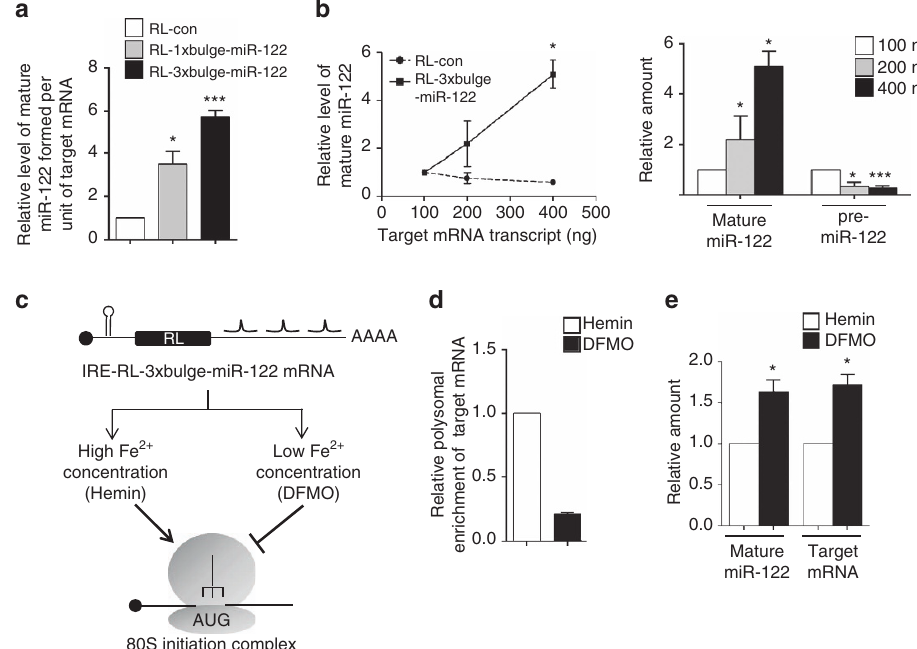
Figure 3 | Effect of target mRNA concentration on substrate-dependent miRNA increase in human cells. ( a ) Amount of mature miR-122 formed per unit of target mRNA in HEK293 cells transfected with pmiR-122 and respective reporter plasmids. Values were calculated by normalizing the amount of mature miR-122 against the amount of respective target mRNA level and plotted. ( b ) Effect of increasing concentration of target mRNA on mature miRNA levels. HEK293 cells expressing pre-miR-122 were transfected with increasing amounts of in vitro -transcribed mRNA (RL-con or RL-3 (cid:2) bulge-miR-122) and mature miR-122 and pre-miR-122 levels were quantified 6h post transfection. In the left panel, changes in relative level of mature miR-122 has been plotted for experiments done with RL-con or RL-3 (cid:2) bulge-miR-122. Relative change of mature and pre-miR-122 in the presence of different amounts of RL-3 (cid:2) bulge-miR-122 was plotted (right panel). Values obtained with 100ng of transcript to transfect 2 (cid:2) 10 5 cells were considered as 1. ( c ) IRE-RL-3 (cid:2) bulge-miR-122 mRNA with Ferritin IRE element in 5 0 -UTR is schematically depicted. ( d ) Cells transfected with pre-miR-122 and IRE-RL-3 (cid:2) bulge-miR-122 were split 24h post transfection and iron chelator DFMO (100 m M) or Fe 2 þ source Hemin (50 m M) was added after an additional 6h. Cells were harvested after 16h post Hemin or DFMO addition for analysis. Polysomal enrichment of IRE-RL-3 (cid:2) bulge-miR-122 was estimated by normalizing polysomal mRNA content by total mRNA level. ( e ) Target mRNA and mature miR-122 level were measured in cells treated with either Hemin or DFMO. Paired two-tailed Student’s t -tests were used for all comparisons. * P o 0.05, ** P o 0.01 and *** P o 0.001. In a – e , error bars represent